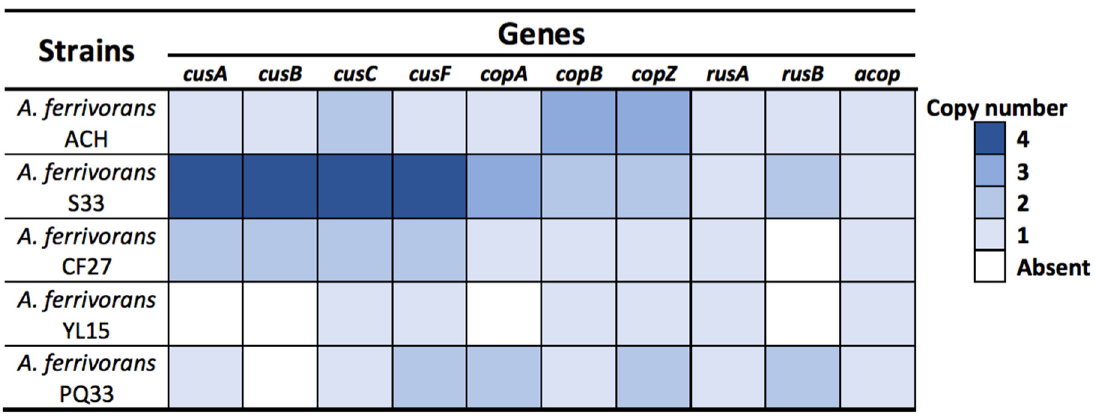
Figure 3. Presence / absence of copper genomic determinants in the A. ferrivorans species. The heat scale shows the copy numbers of each gene present in the genome of all A. ferrivorans strains.